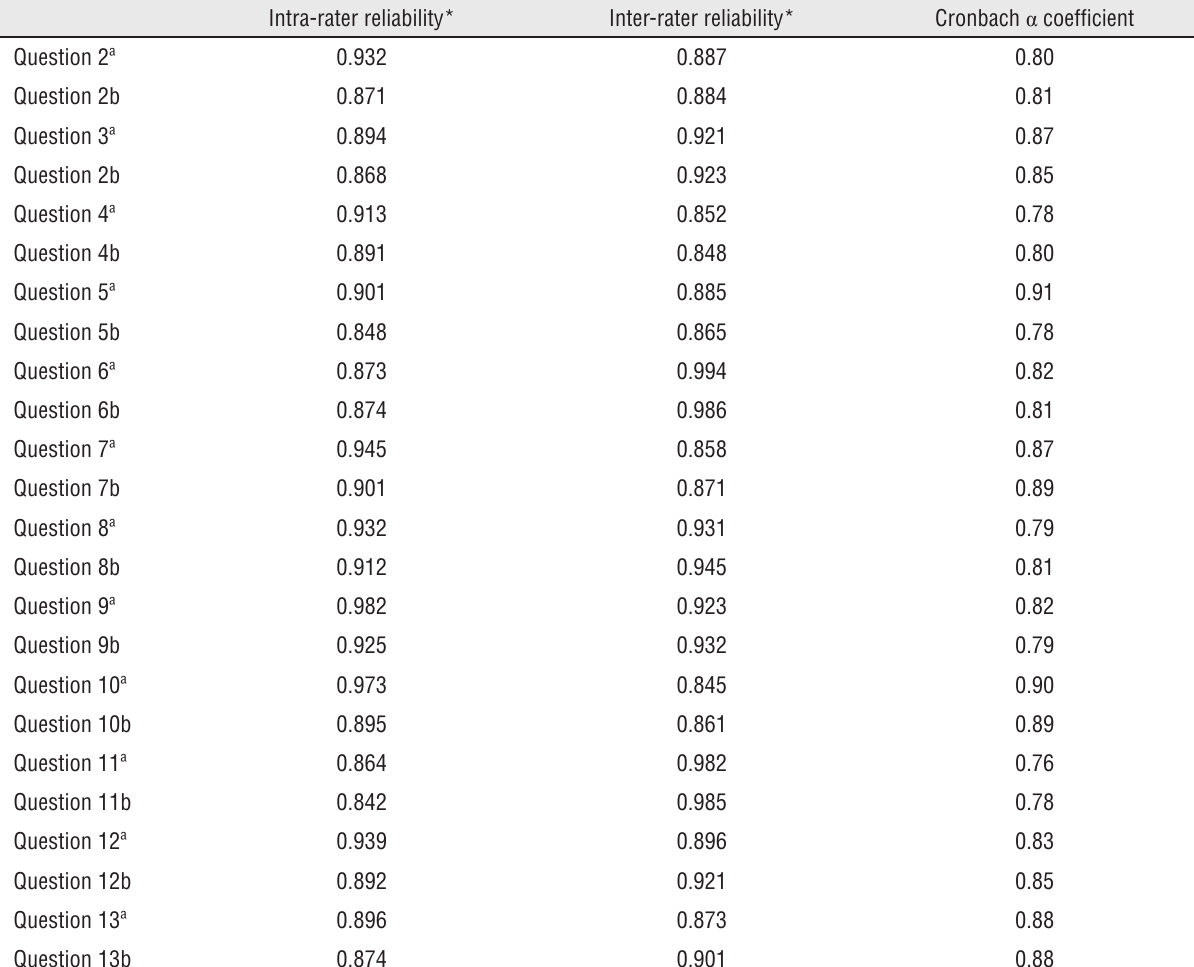
Table 2 - Intra and inter-rater reliability analysis of the